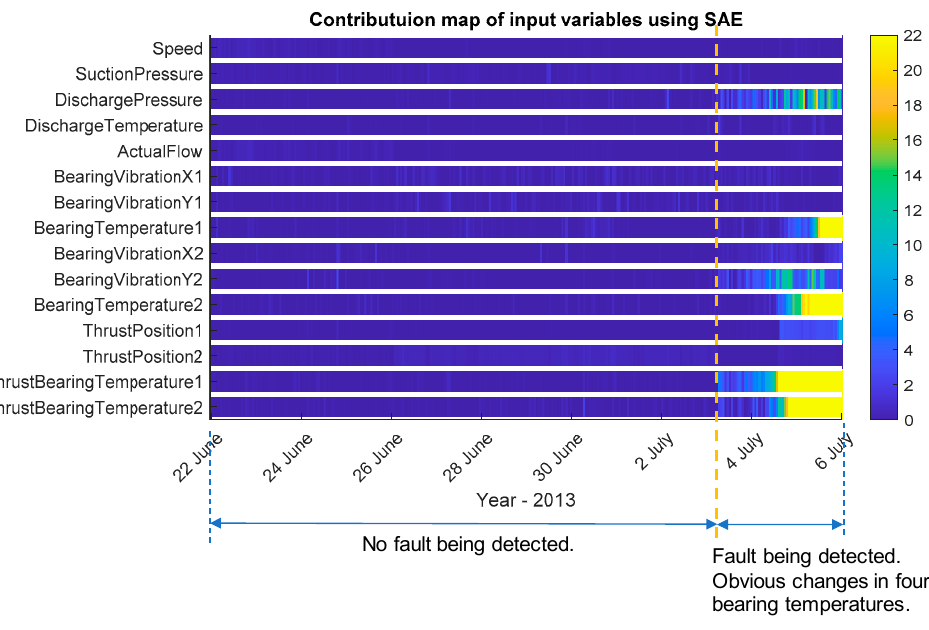
Figure 8. Contribution map by SAE model from 22 June 2013 to 6 July 2013.